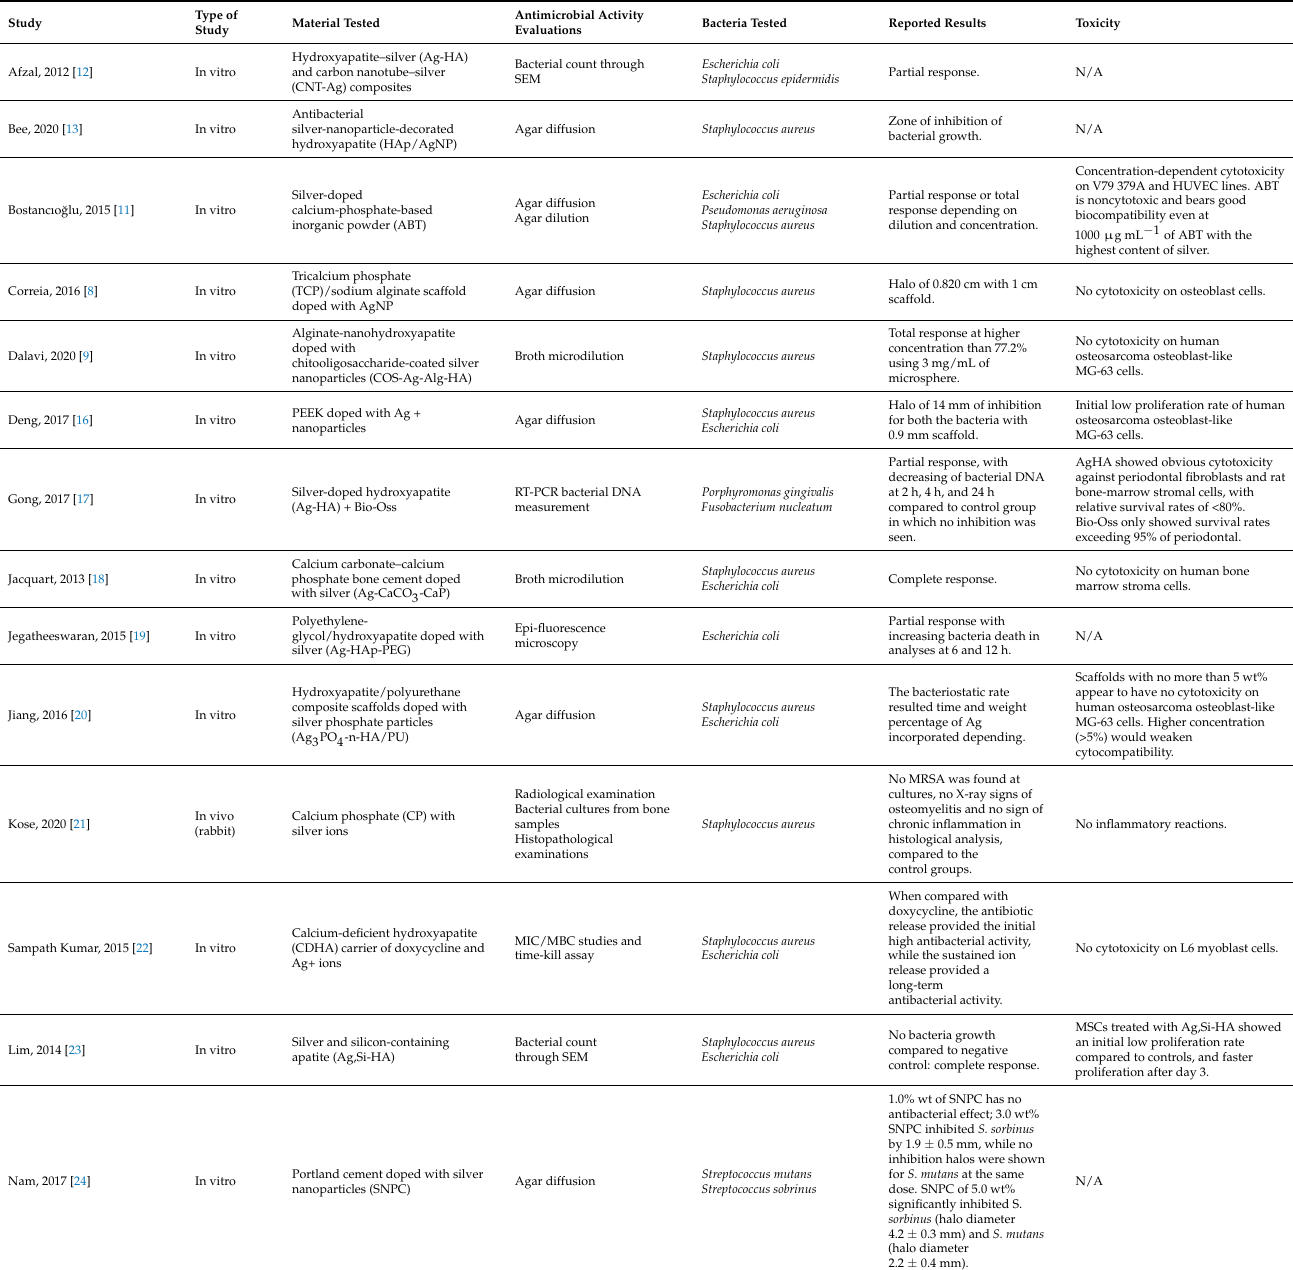
Table 1. Data from included